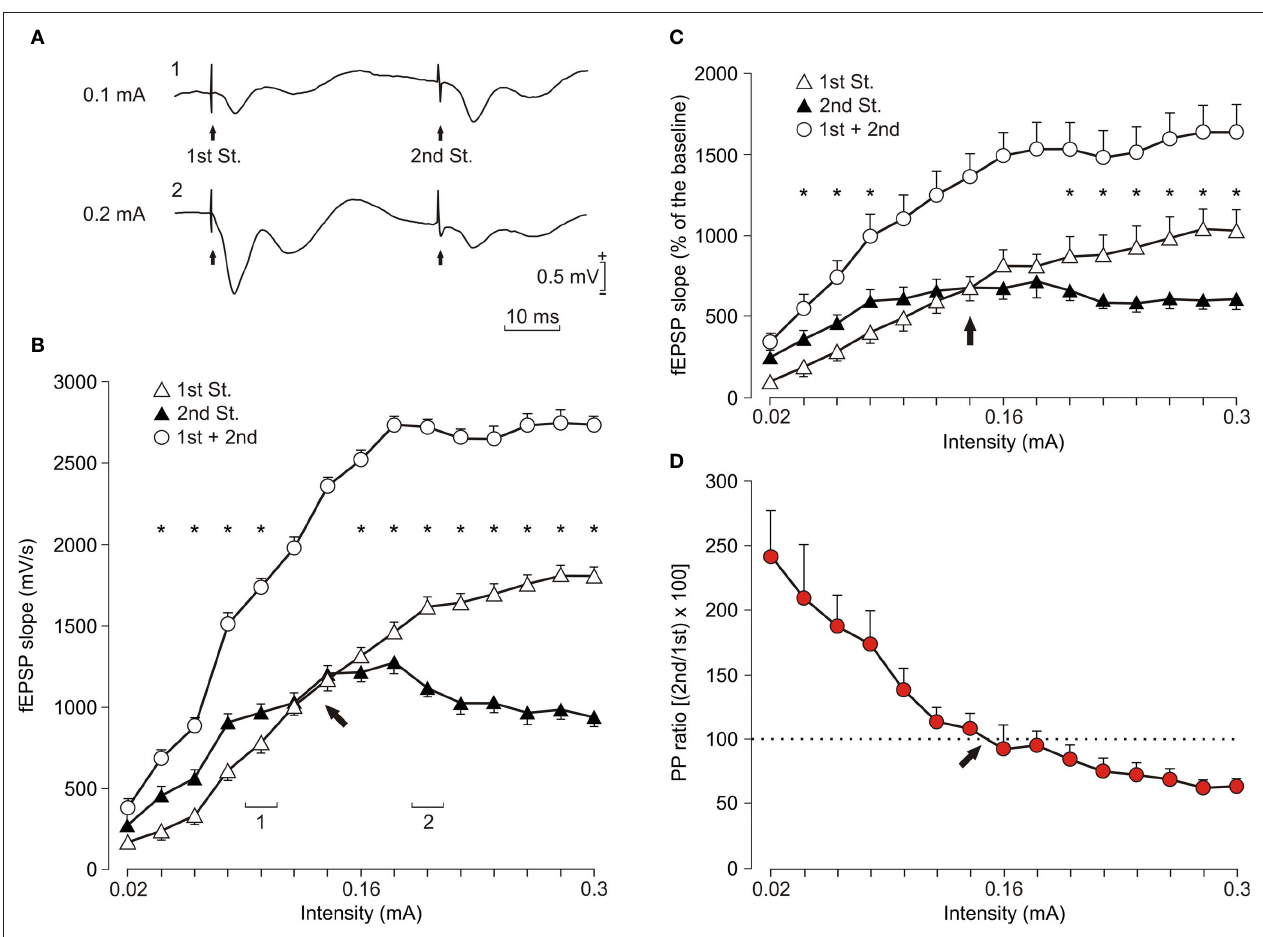
FIGURE 2 | Input/output curves of the CA3-CA1 synapse using paired- pulse stimulation. (A) Representative averaged ( n = 3) records of fEPSPs recorded in the CA1 area following paired (1st and 2nd St., at 40 ms inter- stimulus interval) stimulation of the ipsilateral Schaffer collaterals at two different (1: 0.1 mA and 2: 0.2 mA) intensities. (B) Relationships between the intensity (in mA) of pairs of stimuli (40 ms inter-stimulus interval) presented to Schaffer collaterals and the slope of the fi eld EPSPs evoked at the CA1 layer, corresponding to the 1st (white triangles) and the 2nd (black triangles) pulses.